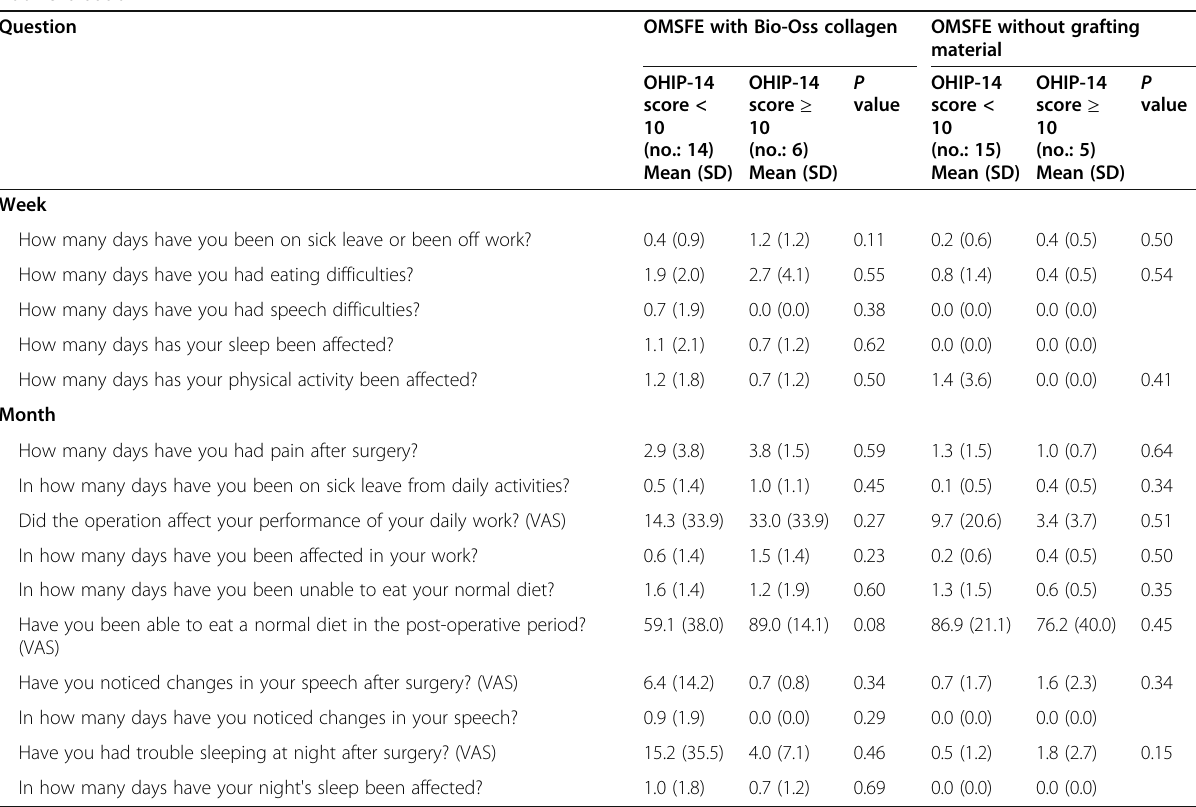
Table 8 Correlation between OHIP-14 item score at enrolment and patient ’ s perception of recovery after osteotome-mediated sinus floor